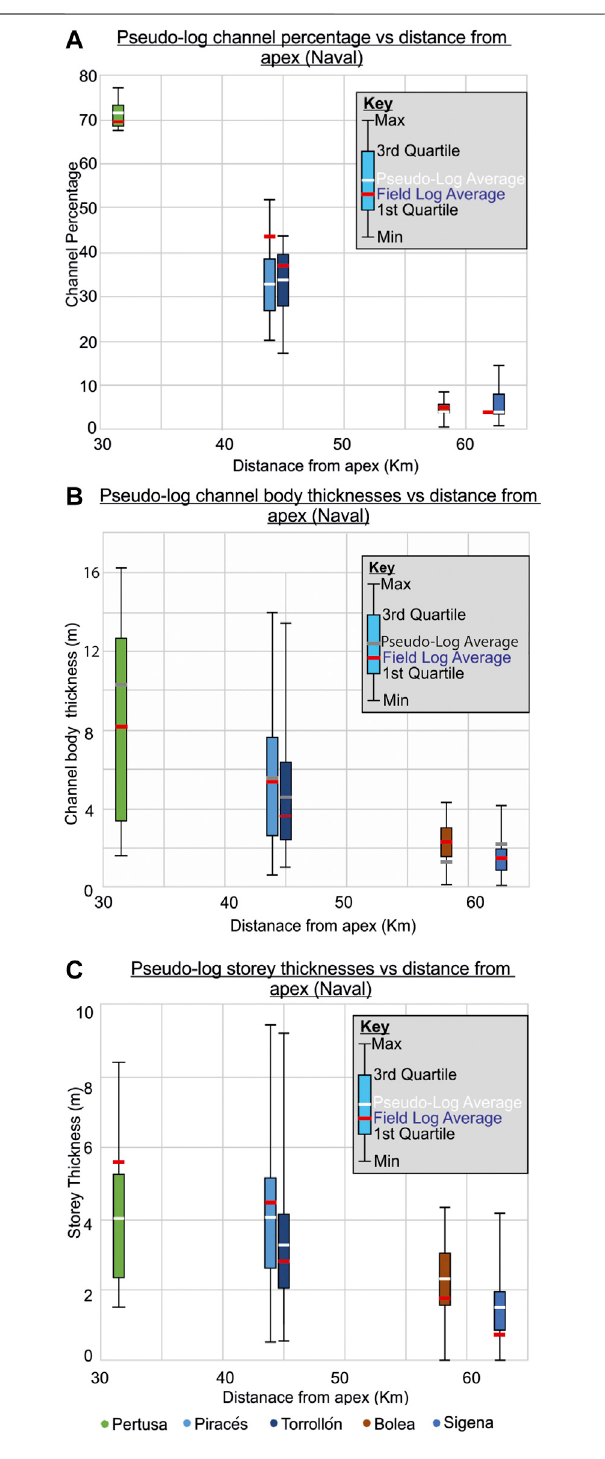
FIGURE7| Spatialtrendspresentfordatacollectedfromvirtualoutcrop models (pseudo-logs). The average from fi eld logs is noted for comparison on each box and whisker plot. (A) Calculated channel percentage from virtual outcrop models vs. distance downstream. (B) Calculated channel body thickness from virtual outcrop models vs. distance downstream. (C) Calculated storey thickness vs. distance downstream.